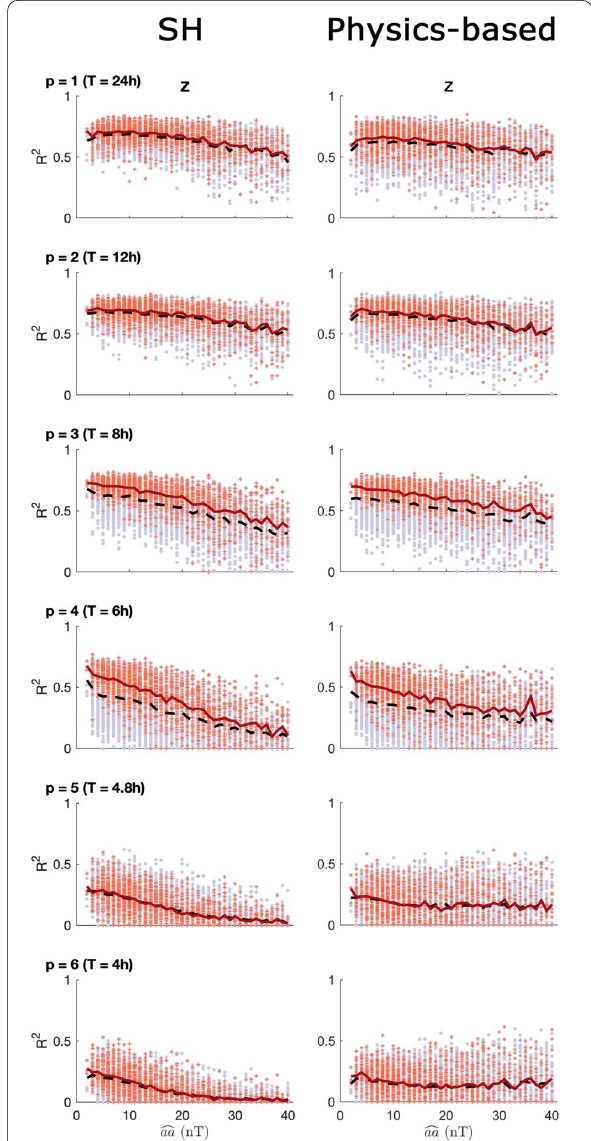
Fig. 10 Same as in Figure 9 but for Z